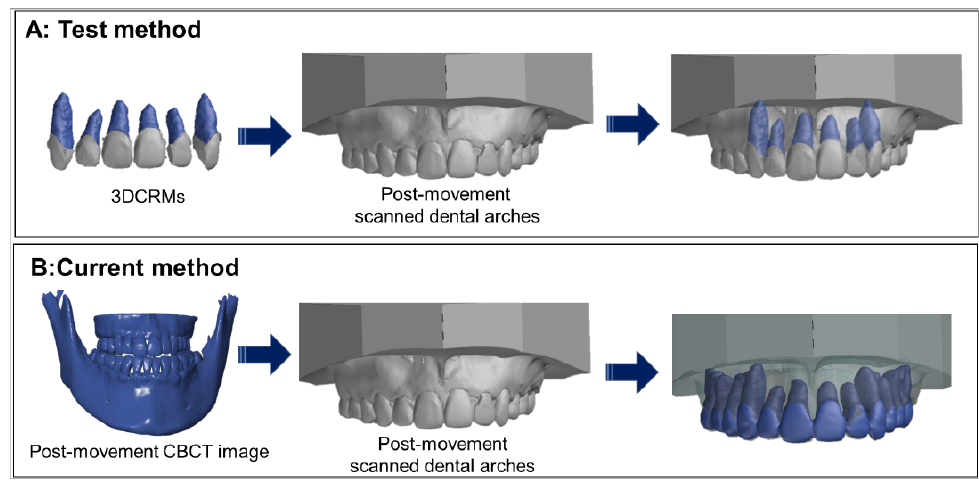
Figure 2. Determination of the post-movement root position by the test method and the current method. ( A ): The test method; the individual 3DCRMs were superimposed on the post-movement scanned dental arches with the crown shape as an index. ( B ): The current method; post-movement CBCT data were superimposed on the post-movement scanned dental arches.